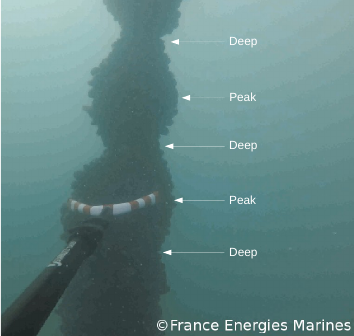
Figure 6. Bulbs of mussels defined by alternating deeps and peaks.